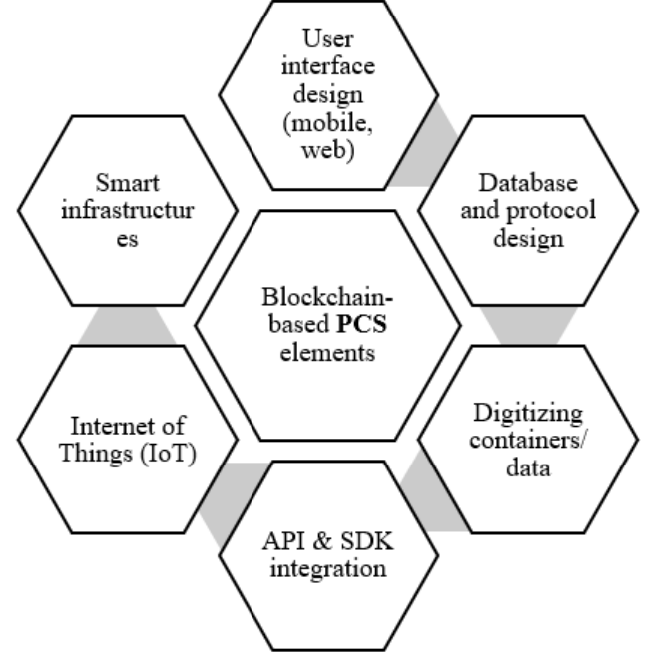
Figure 6. Blockchain-based PCS design components.